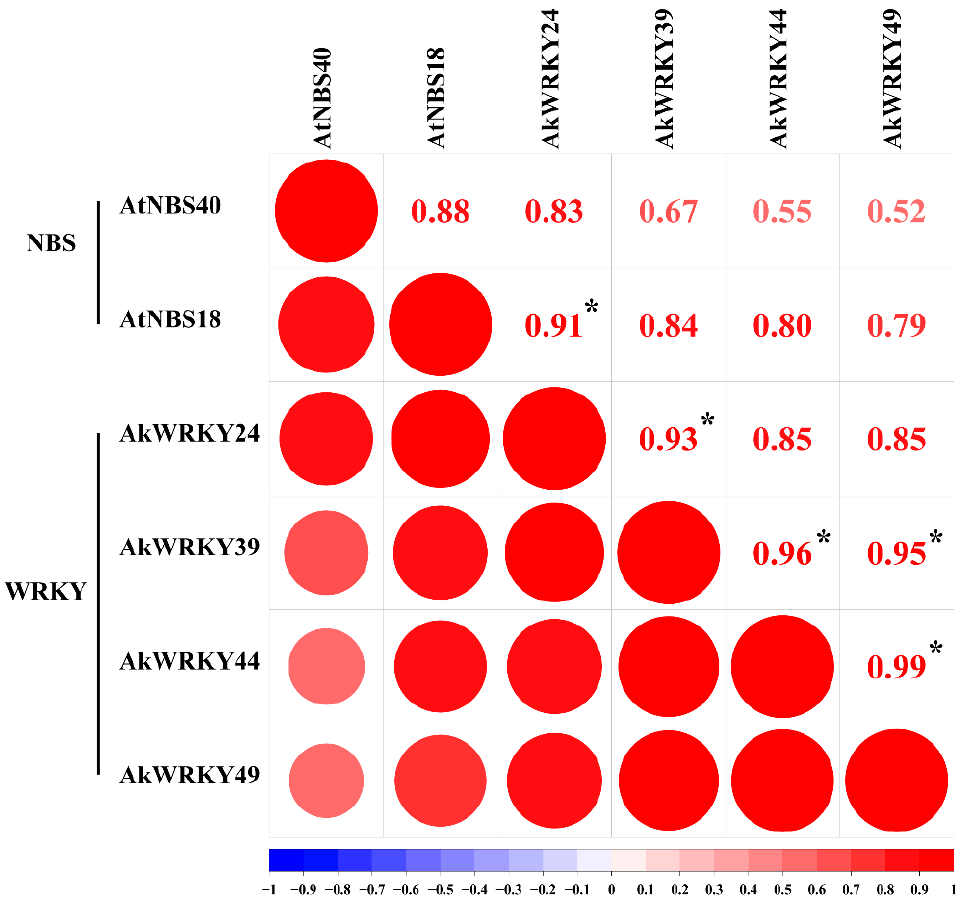
Figure 6. The correlation between the gene expression patterns of two AkNBS genes and four AkWRKY genes. * Indicates a significant correlation at p = 0.05 level.